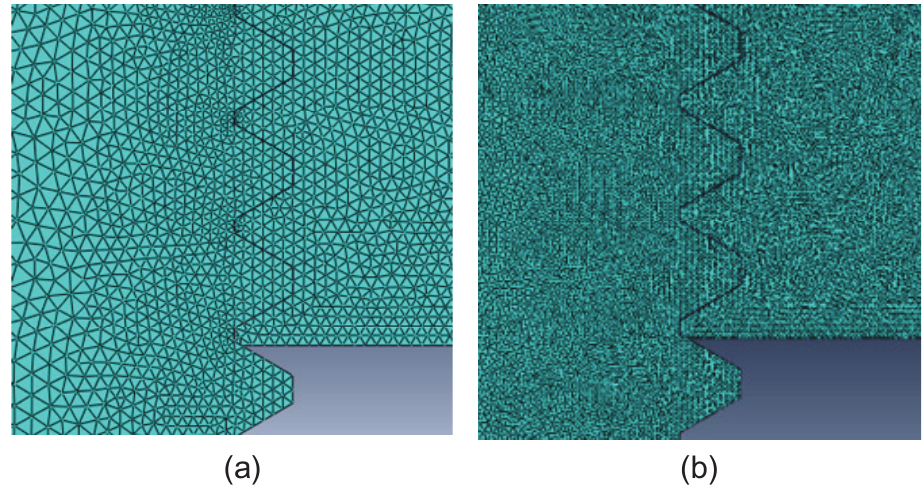
Figure 5. Demonstration of the ( a ) coarse mesh and ( b ) fine mesh examined during the mesh sensitivity analysis .